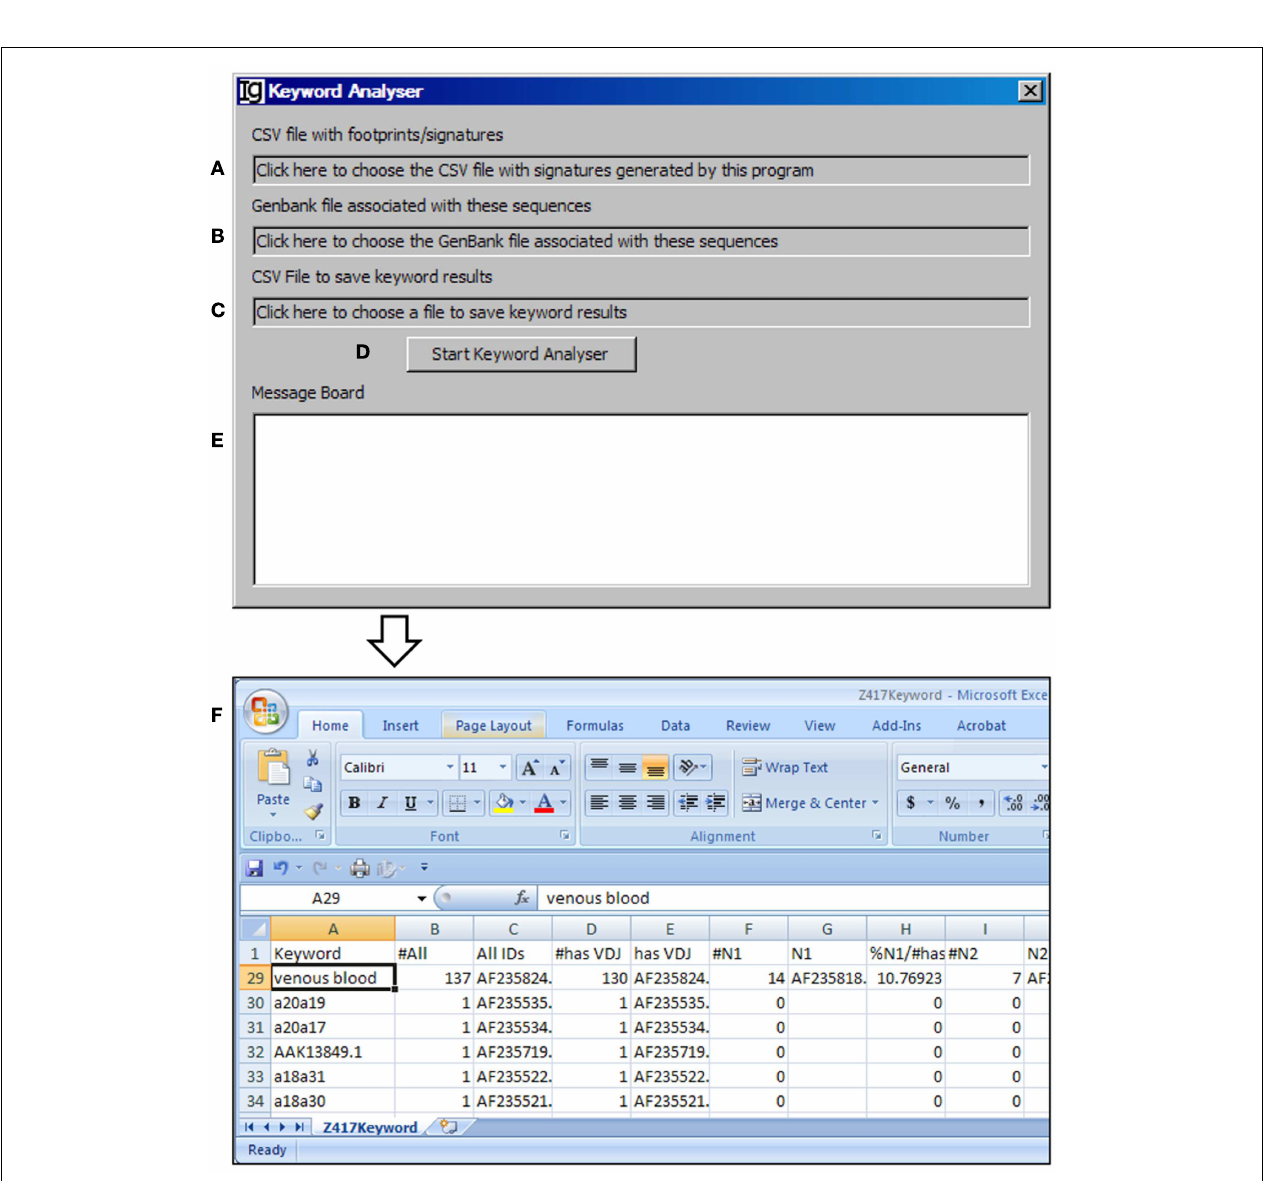
FIGURE 6 |The keyword analyzer . Diagram shows the interface of the Keyword Analyzer . (A) Textbox to choose theV H replacement footprint analysis result file. (B) Textbox to choose the GenBank file with theV H replacement footprint analysis result file. (C) Textbox to choose the output file. (D) Button to start the analysis process. (E) Window area to show the message during analysis progress. (F) Examples of list of keywords associated with the Z417 test sequences.